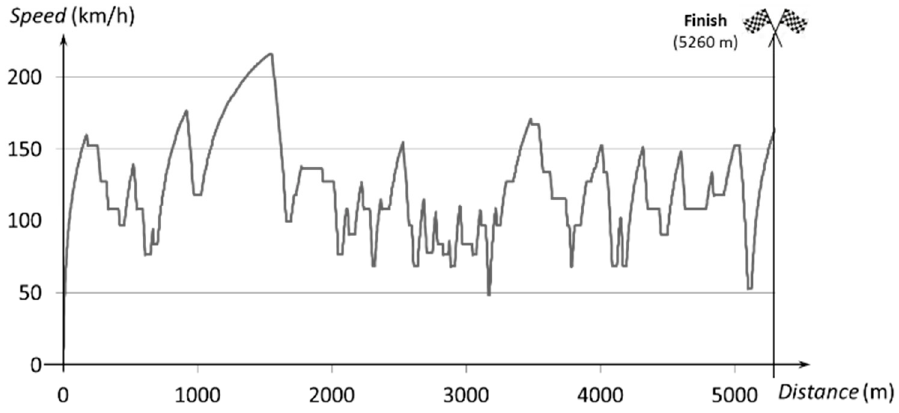
Figure 8. Speed vs. distance using the optimized chassis.